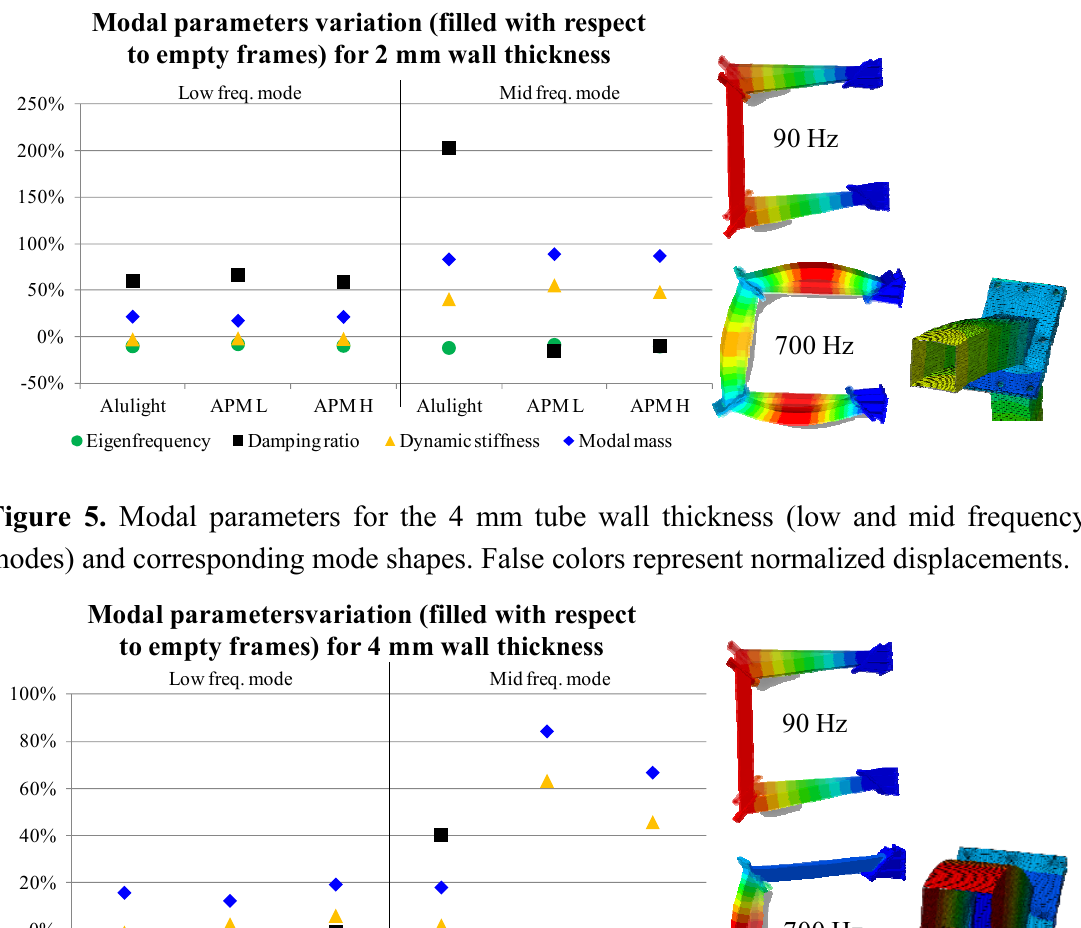
Figure 4. Modal parameters for the 2 mm tube wall thickness (low and mid frequency modes) and corresponding mode shapes. False colors represent normalized displacements.